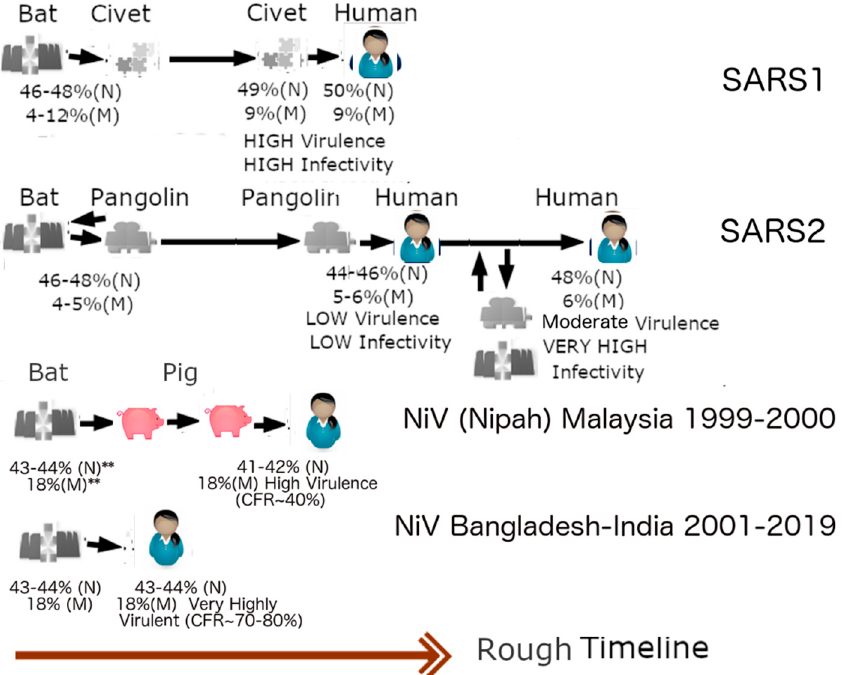
Figure 4. Zoonotic Relationships and Virulence. The introduction of SARS1 (SARS ‐ CoV ‐ 1) into humans may be linked to an intermediary involving civet cats. Because of the higher virulence of SARS1, in comparison to SARS2 (SARS ‐ CoV ‐ 2), and the high genetic similarity of SARS ‐ CoV1 and Civet ‐ CoV, it can be suspected that SAR1 entered civets for a short while before entering humans. The lower virulence of SARS ‐ CoV ‐ 2 leads us to believe that the virus may have been incubating in an intermediary involving a burrowing animal such as pangolin for a relatively longer period of time. The case of Nipah virus illustrates this point. The virus involved in the 1999–2000 Malaysian outbreak is less virulent than the viruses involved in outbreaks in Bangladesh and India because the former involved an intermediary, i.e., farm pigs. The reason that SARS ‐ CoV ‐ 1 (SARS1) was more virulent is likely that it was in an intermediary host (palm civet cat) for a relatively short period. SARS ‐ CoV ‐ 2, (SARS2), unlike SARS1, could have been incubating among pangolins for a long time before its arrival among humans as a relatively more attenuated virus, in comparison to SARS1e. Omicron is likely to have arisen from a backward transmission to a burrowing animal such as pangolin. It is also possible that a non ‐ Omicron variant re ‐ entered the pangolin population already infected with Omicron and recombinations occurred. (Taken in part from Biomolecules. 2022;12(5). © 2022 Goh et al, Published by MDPI AG, Open access under CC BY ‐ NC ‐ ND license. This is an Open Access article which permits unrestricted non ‐ commercial use, provided the original work is properly cited. [21]).